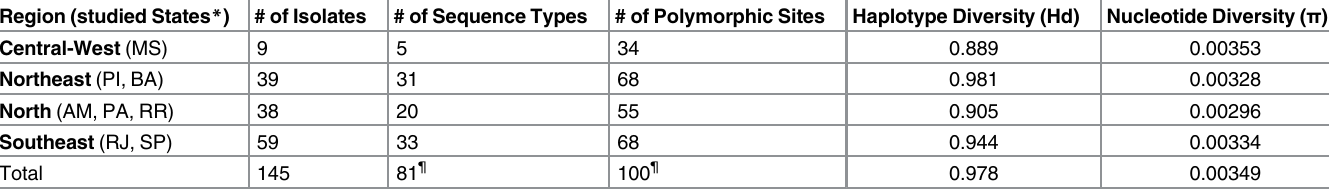
Table 1. Characteristics of the studied Brazilian regions. Region (studied States * ) # of